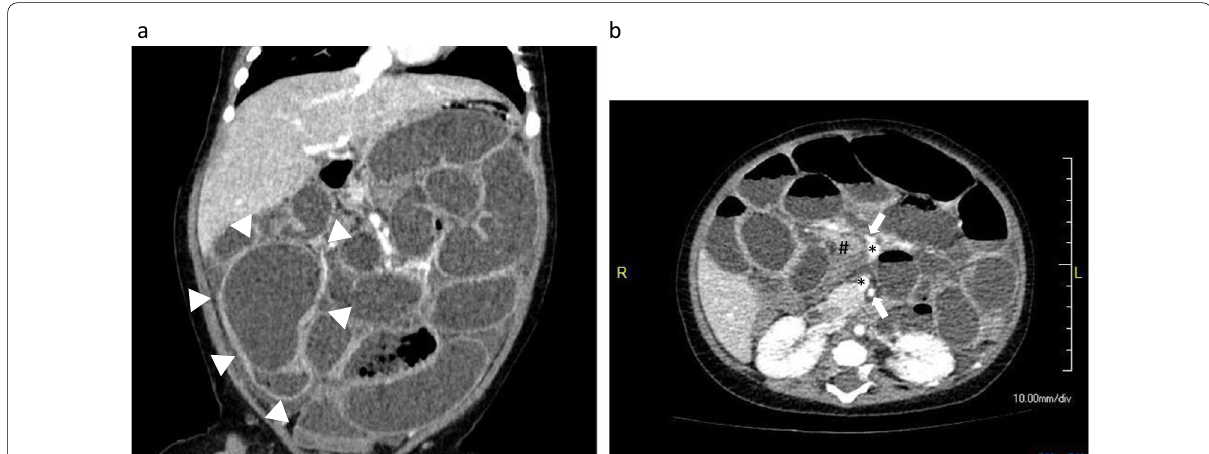
Fig. 1 Contrast-enhanced computed tomography images of Case 1. a Cystic mass (50 mm, arrowheads) in the terminal ileum with compressed normal ileum was observed. b Stretched edematous mesentery (#) caused by twisted and dilated small intestines was observed (arrows: superior mesenteric artery; *superior mesenteric